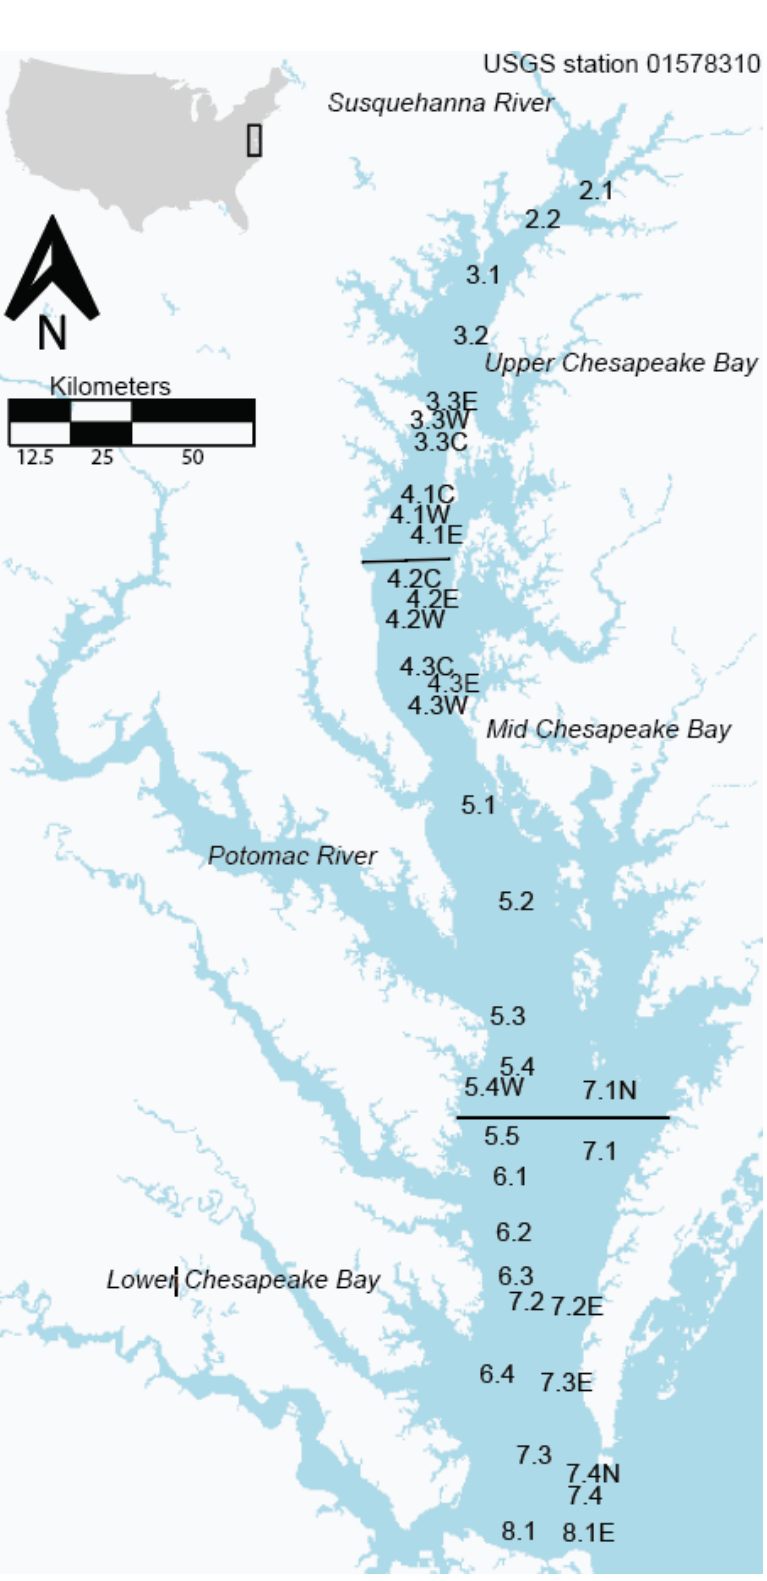
Figure 1. Map of the study area, showing each monitoring station from the Chesapeake Bay Program used in this study. The map is based on a 300-m OLCI image, the same spatial resolution used from the RE10